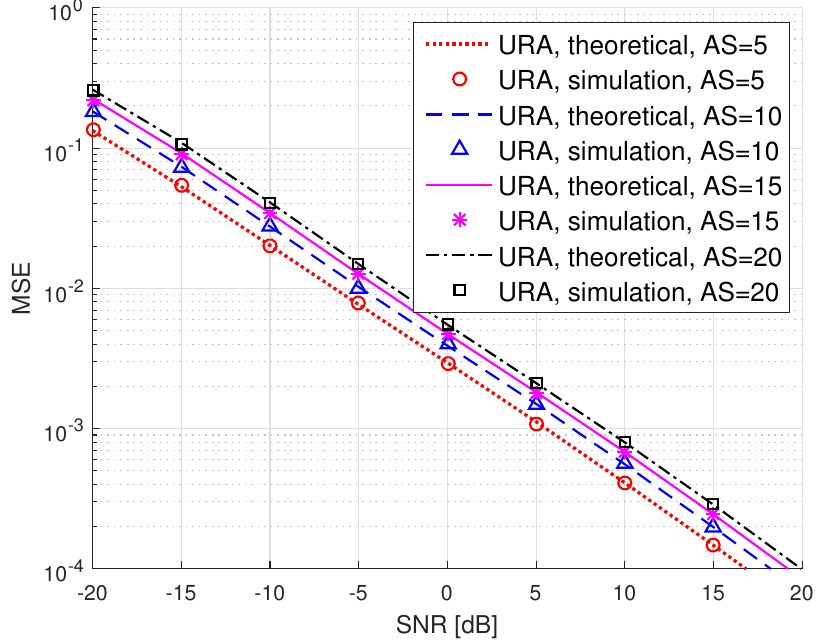
Figure 7. MSE vs. SNR in dB using the URA topology, U = 10 UEs, M = 128, with different values of angular spread α A ( AS )